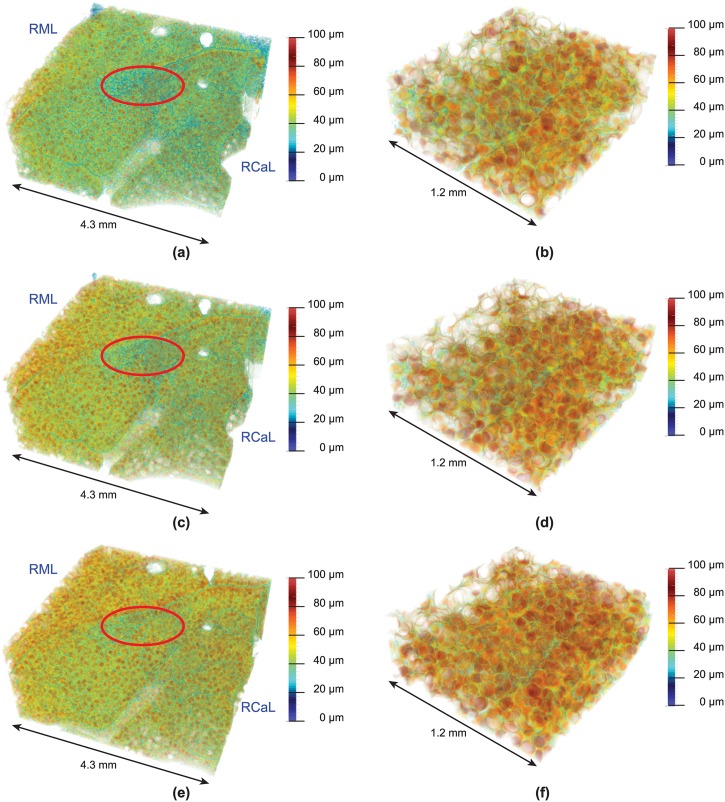
3D air volume thickness maps.Visualization of the air volume thickness maps in 3D: (a),(c) and (e) show the 10, 20 and 30 cmH2O pressures for the 2.9 μm-pixel-size optics; (b),(d) and (f) show the ones for the 1.1 μm-pixel-size optics. RML: right middle lobe; RCaL: right caudal lobe; the red circles indicate areas which at the same air pressures exhibit a smaller expansion of the individual airspaces. With higher pressures more orange-to-red colored volumes are visible, i. e. air volumes with structural thicknesses of 50 − 80 μm.